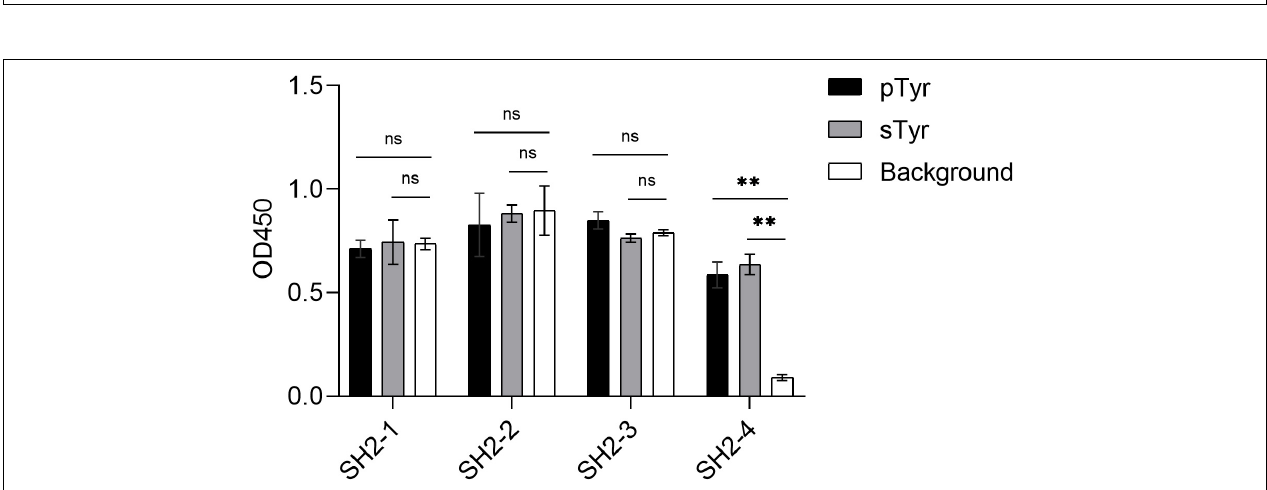
FIGURE 5 | Phage ELISA of the variants SH2-1–SH2-4 binding to pTyr and sTyr peptides and the background. Streptavidin precoated in the microplate was taken as the background. Three replicates were performed, and the p -value was performed with Student’s t -test (ns, no significant; ∗∗ p < 0.01).